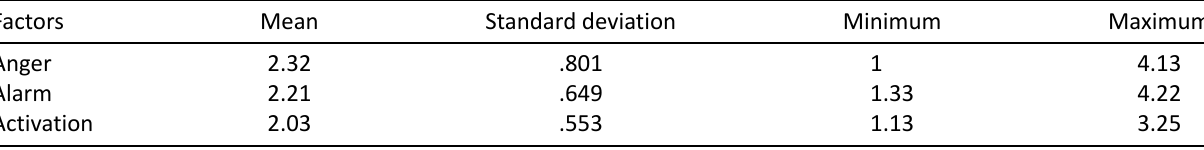
Table 2. Descriptives of the introduced affect